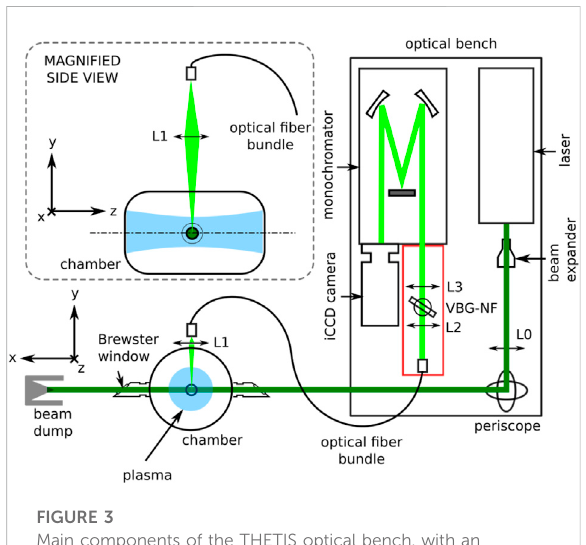
FIGURE 3 Main components of the THETIS optical bench, with an illustration of an example implementation on a vacuum vessel (views not to scale). This depiction shows the laser light (dark green) sent across a plasma (blue), with recovery and transmission of the scattered light (light green) for